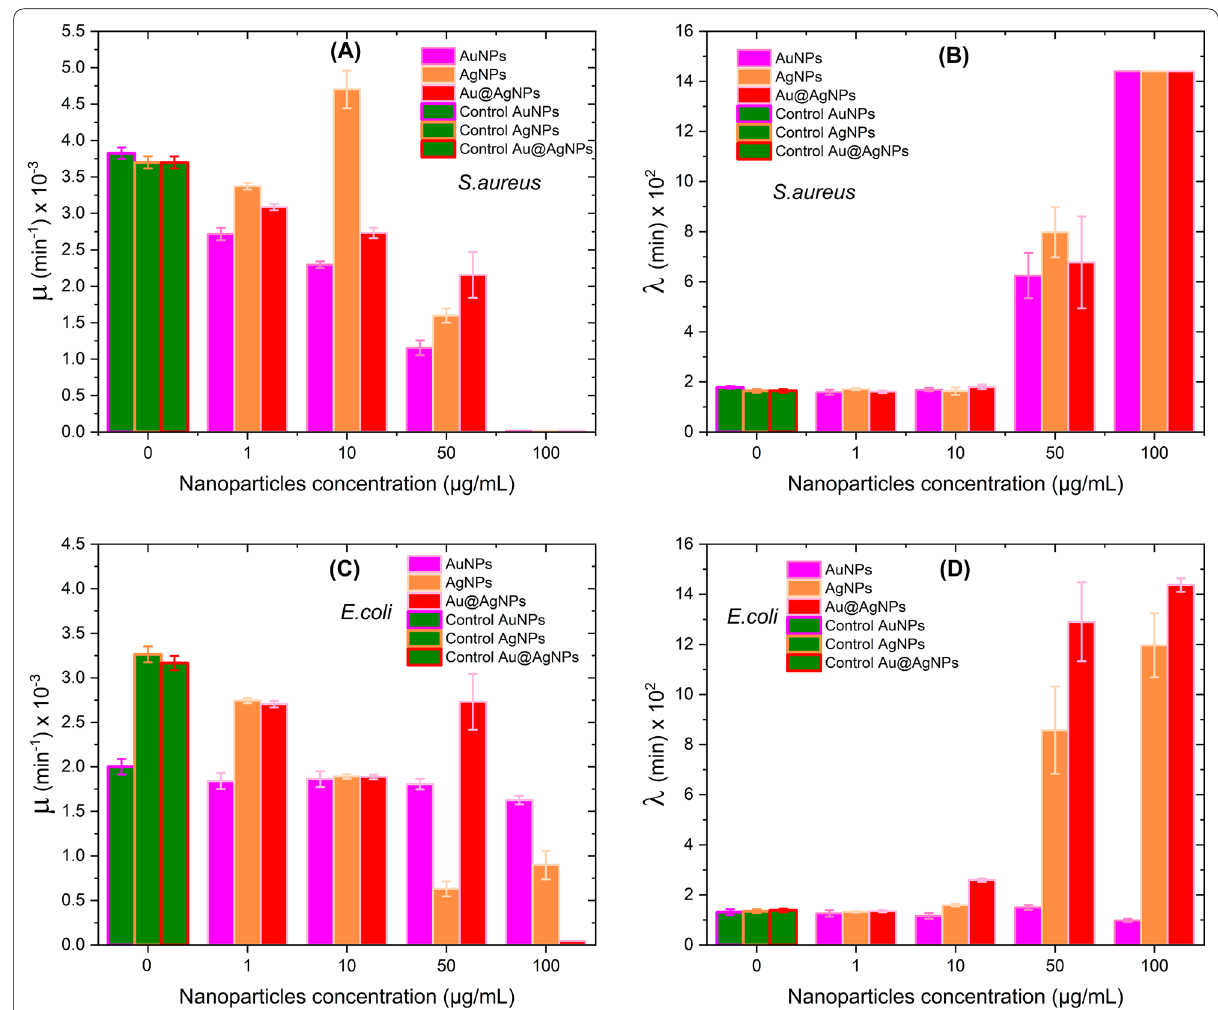
Fig. 10 Kinetic parameters were obtained by the Gompertz model. Growth Rate µ and Time Lag Phase (cid:31) for S. aureus ( a , b ) and E. coli ( c , d